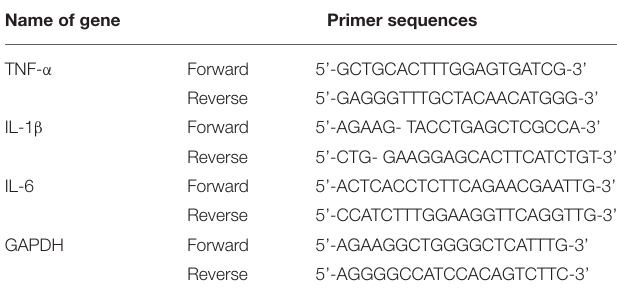
TABLE 1 | Target gene names and PCR